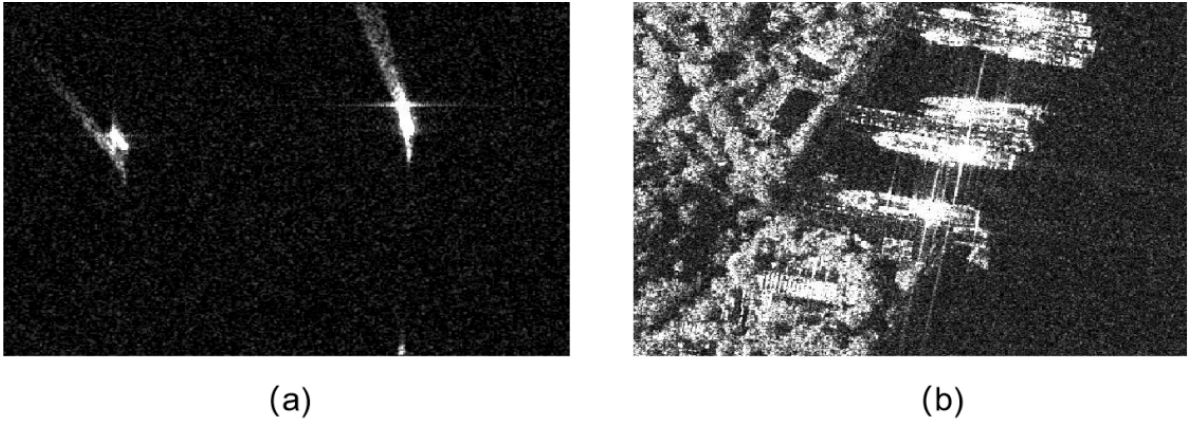
Figure 1. SAR images in different scenes ( a ) without interference; ( b ) multi-scale ships in complex contexts.